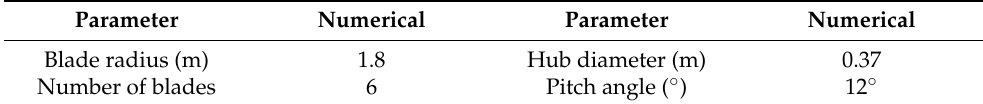
Table 3. Turbine parameters for sea trials.